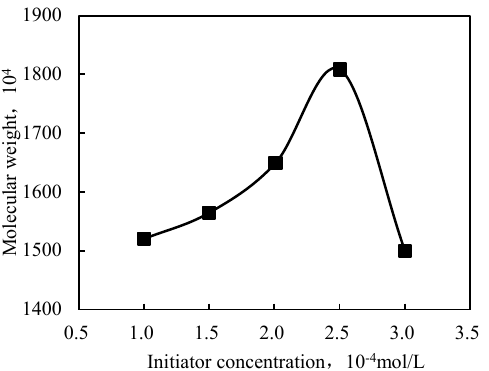
Figure 5. Relationship between the initiator concentration and molecular weight of the intercalated polymer.